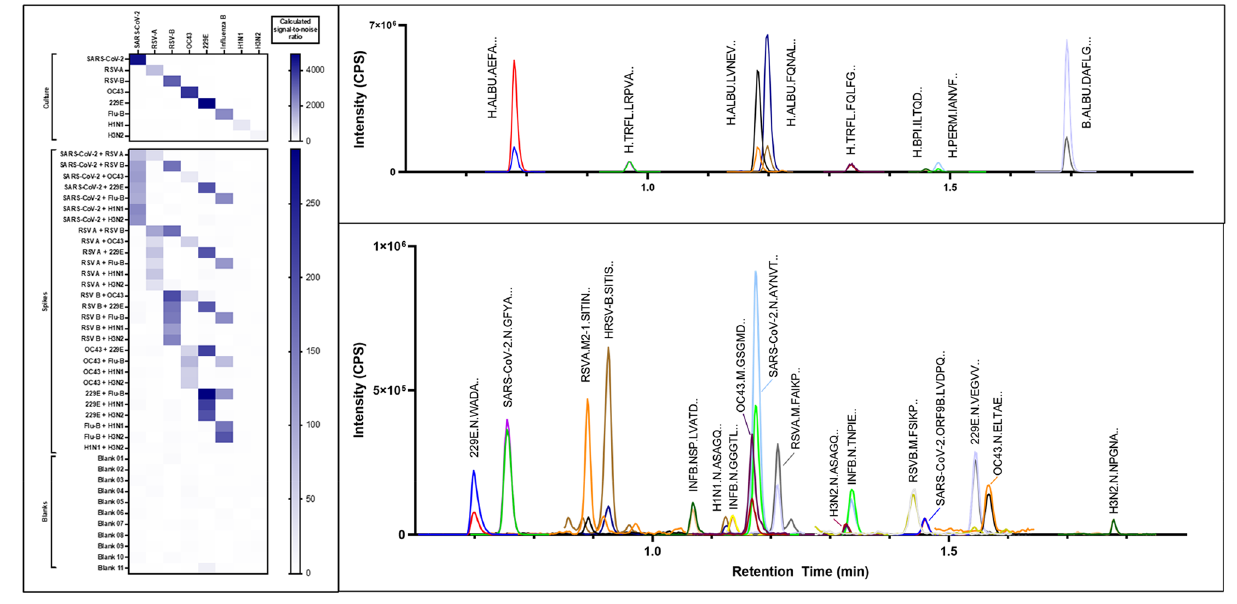
Figure 2. (Left) Heat map of signal-to-noise ratio for combined peak areas of virus spikes (1:9 v/v) versus peak area average of blank samples. (Right) Overlay of MRM chromatograms from human background proteins (upper panel) and virus cultures (lower panel) showing efficient use of MS detection time and minimal concurrency through careful peptide selection and maximising chromatographic separation.